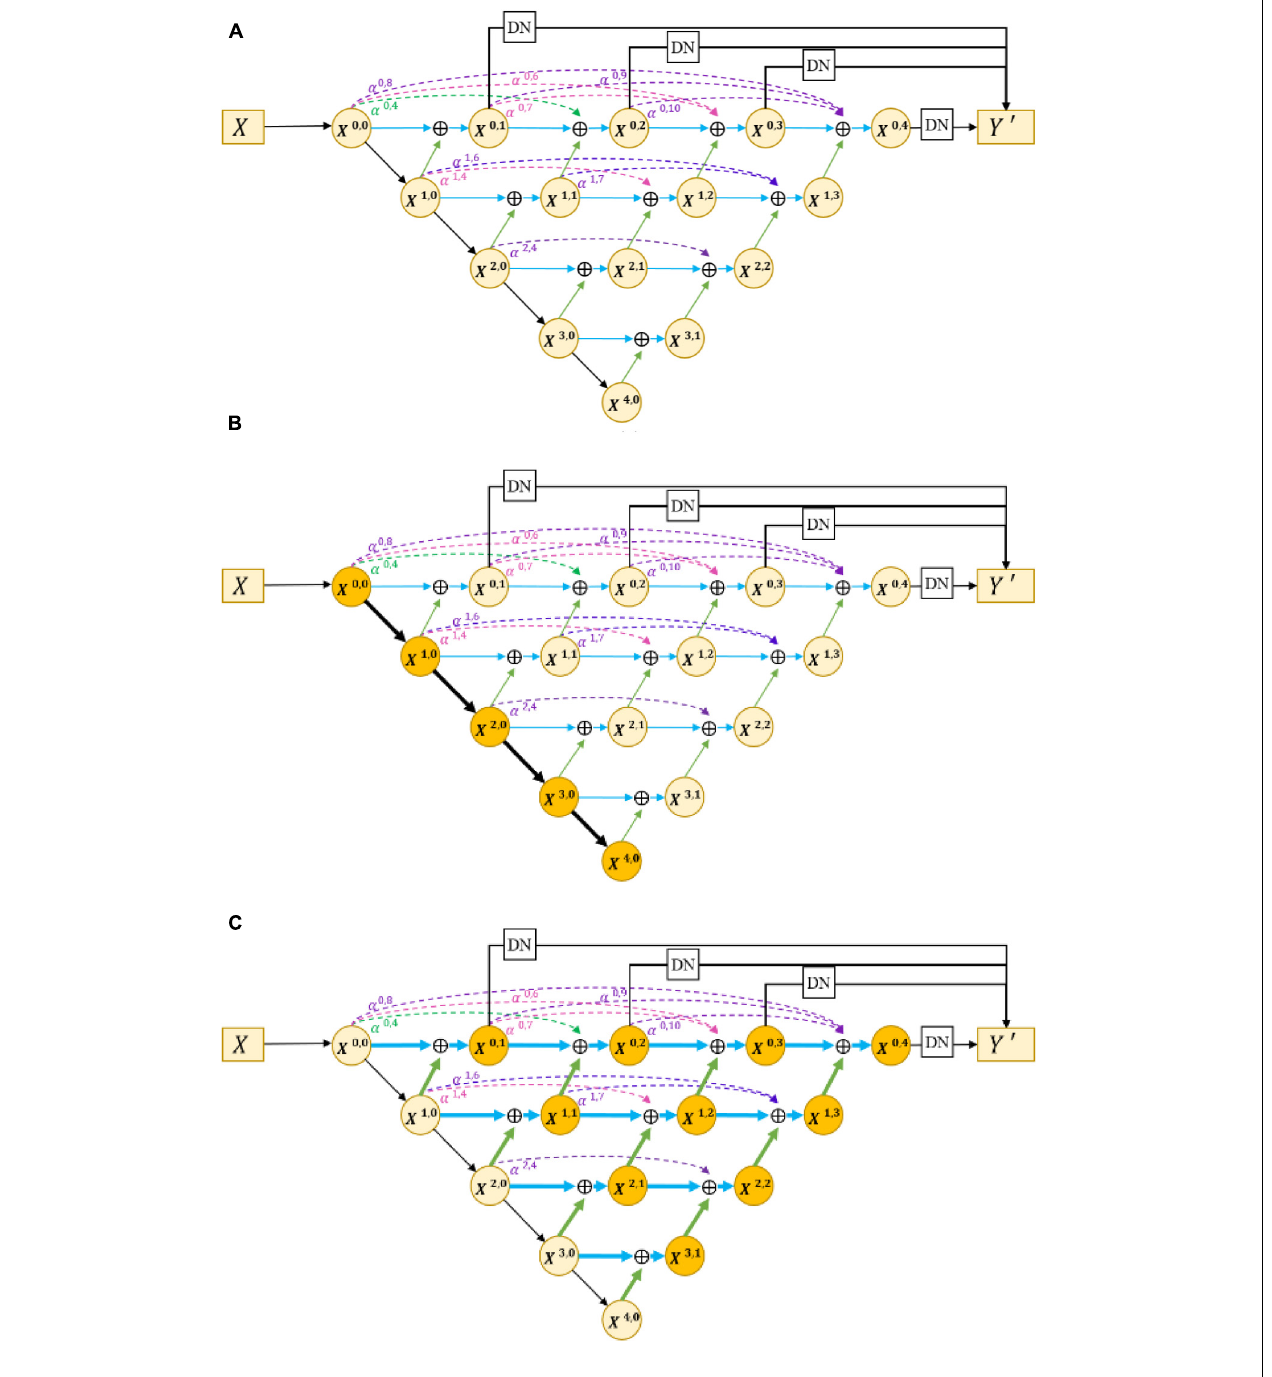
FIGURE 3 | (A) Architecture of the proposed dynamic multi-hierarchical weighting segmentation network (DW-Net). The dark yellow part in (B,C) indicate the residual aggregation encoder path and the dynamic multi-hierarchical weighting connection, respectively.